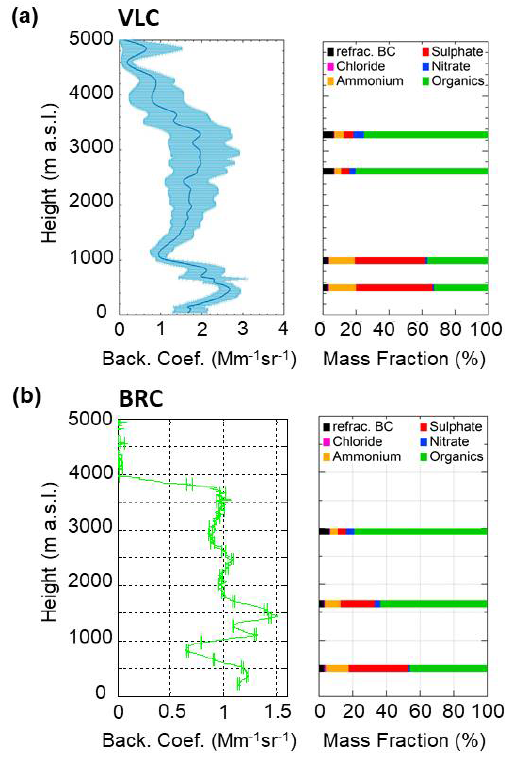
Figure 27. Distinct aerosol layers observed near Burjassot/Valencia (VLC) and Barcelona (BRC). (a) Profile of the backscatter coefficient derived at 910nm for 13:30–14:30UTC in VLC (left), and fractional composition of PM1 measured (SP2 and AMS) aboard HALO (right), (b) the same derived in BRC at 532nm for 14:45–15:45UTC. The periods of comparison with the HALO data are 13:47–13:56 (9min and 30s) at 3300m; 13:34–13:40 (5min and 30s) at 2630m, 14:03–14:14 (11min) at 1000m, and 14:18–14:31 (13min) at 500m for VLC, and 15:43–16:00 (17min) at 2940m; 15:16–15:40 (24min) at 1650m and 14:47–15:14 (27min) at 500m for